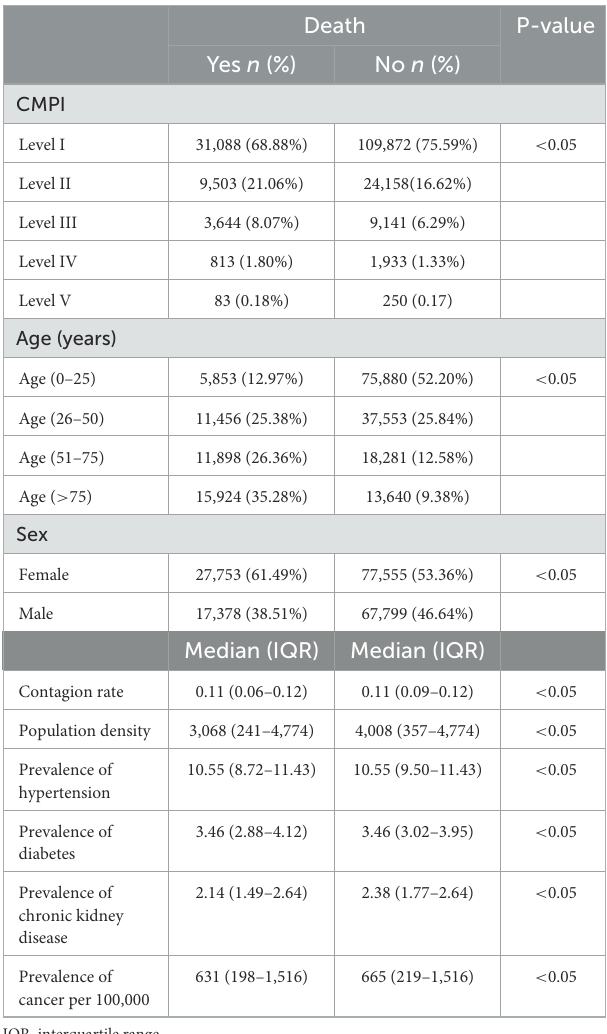
TABLE 1 Sociodemographic factors, socioeconomic characteristics and chronic disease prevalence among deceased and non-deceased patients hospitalized for